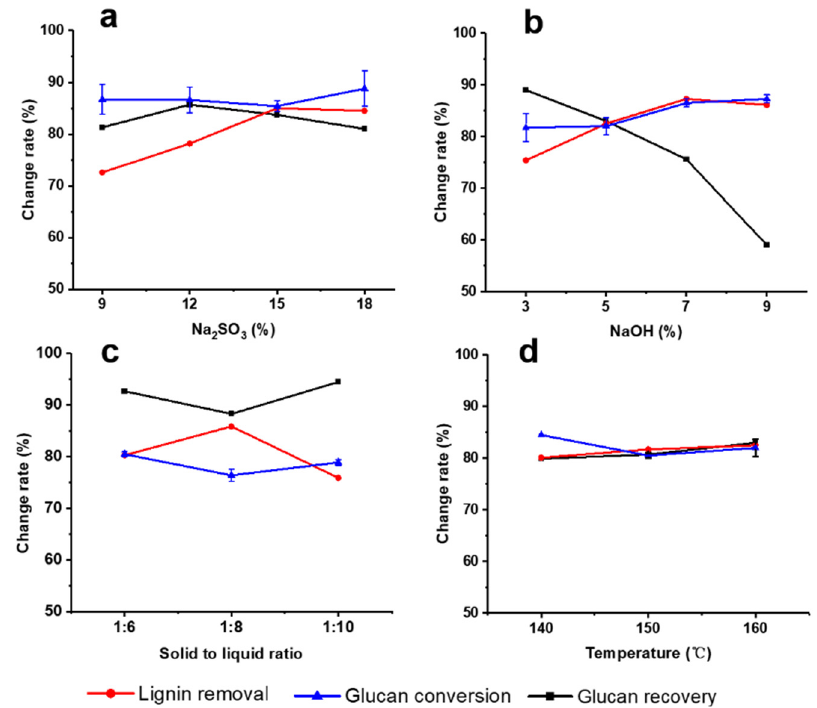
Figure 1. Effects of different ASS pretreatment conditions on lignin removal (circle), glucan recovery (square), and glucan conversion at 72 h of enzymatic hydrolysis (triangle) of DA-pretreated corn stover. ( a ) Na 2 SO 3 dosages; ( b ) NaOH dosages; ( c ) solid-to-liquid ratio; ( d ) temperature. Here, Na 2 SO 3 and NaOH were simultaneously added to the pretreatment